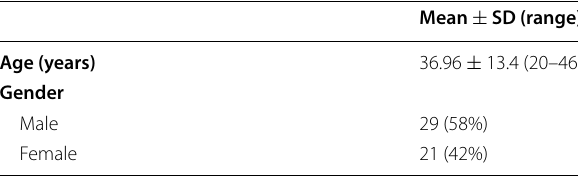
Table 1 Age and gender of the subjects